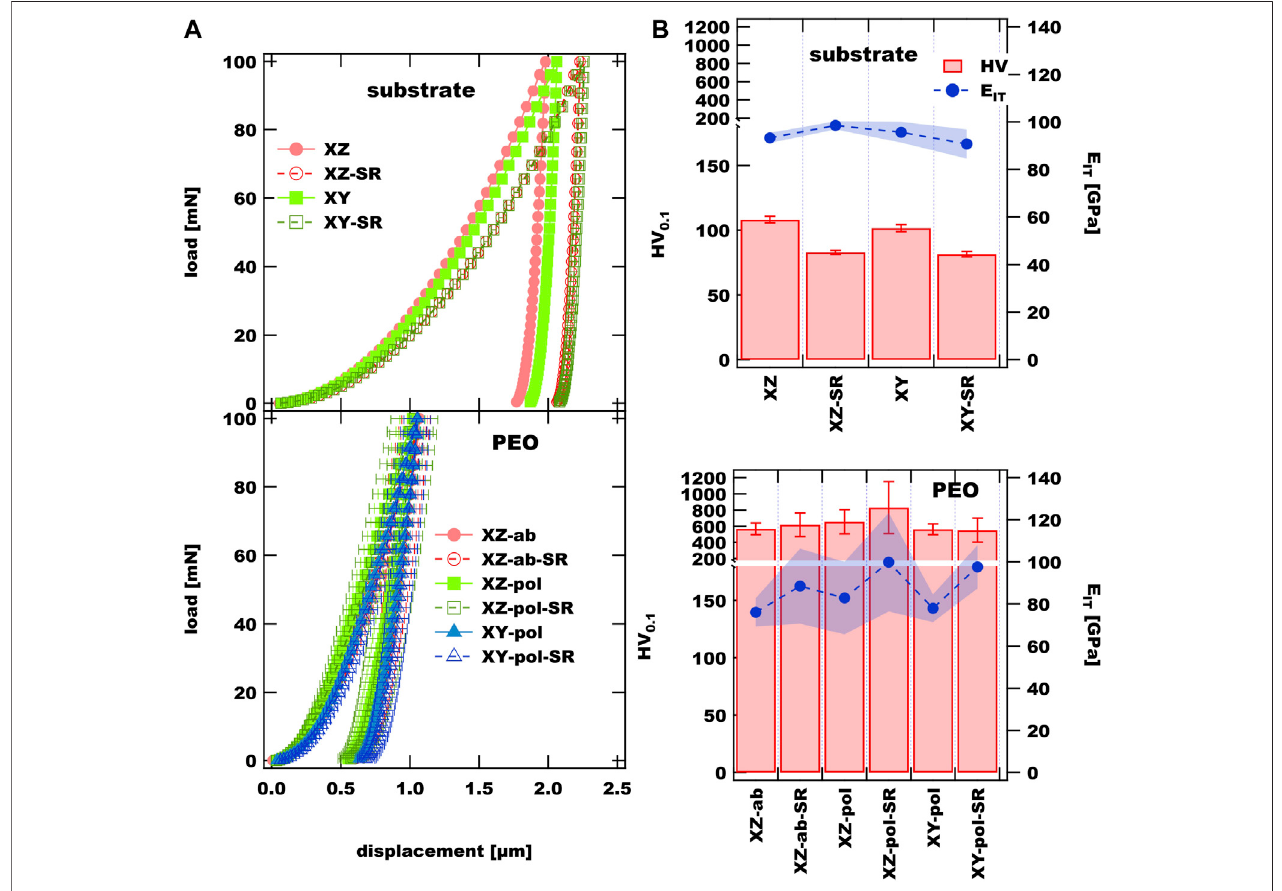
FIGURE 5 | (A) nanoindentation curves of observed substrate materials and PEO coatings; (B) hardness and E IT values of substrate and PEO